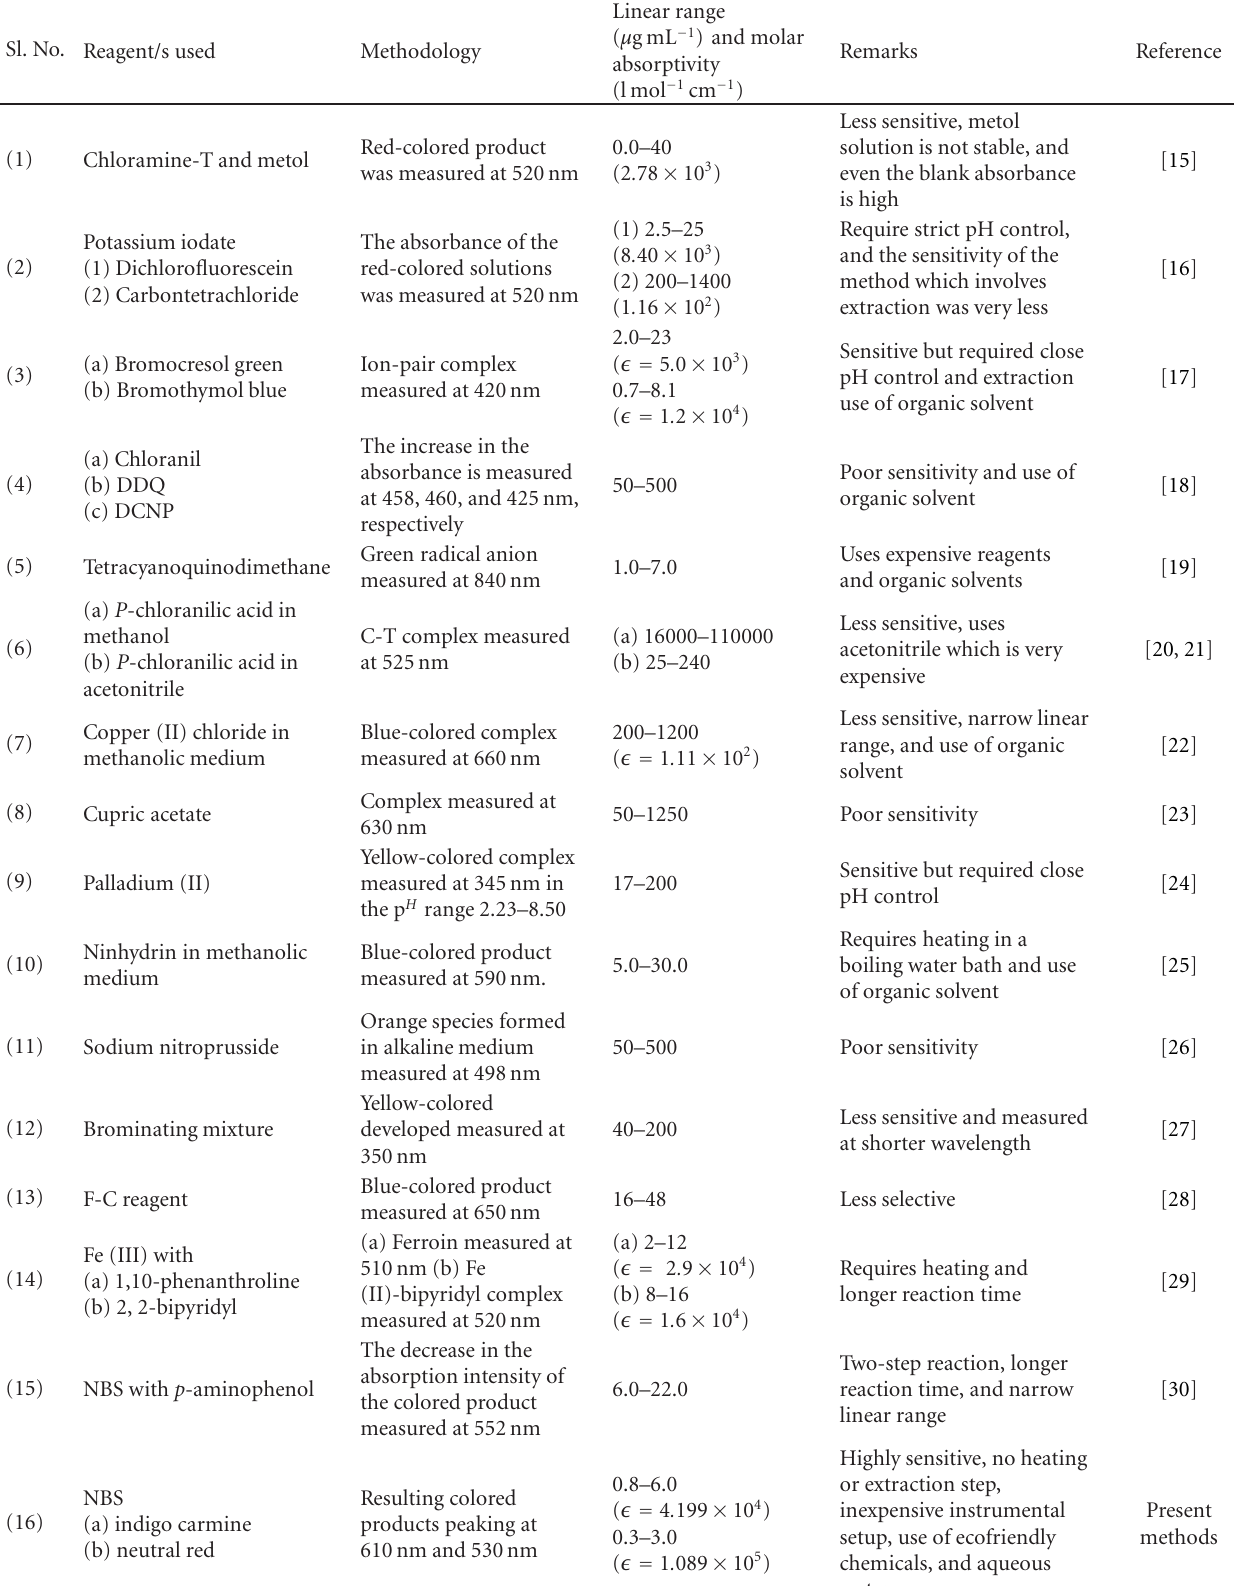
Table 1: Comparison of the performance characteristic of the existing spectrophotometric methods with the proposed methods.